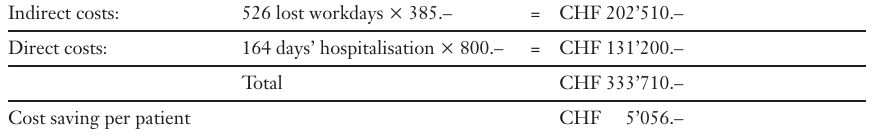
Health costs saved (66